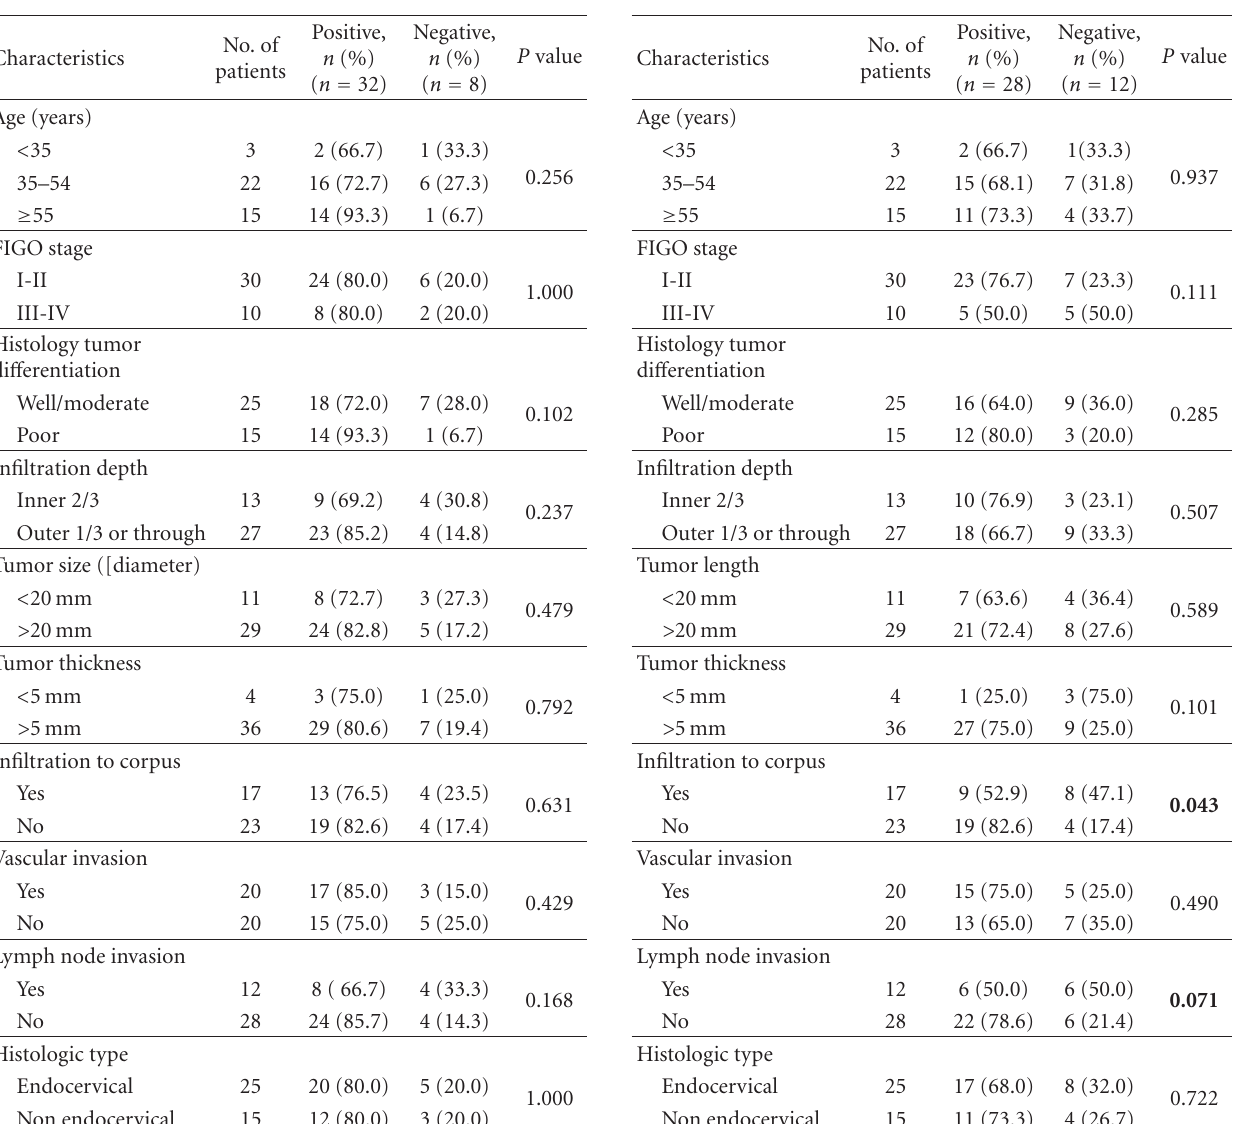
Table 4: Associations between p16INK4a expression and clinico- pathologic parameter for endocervical adenocarcinoma.